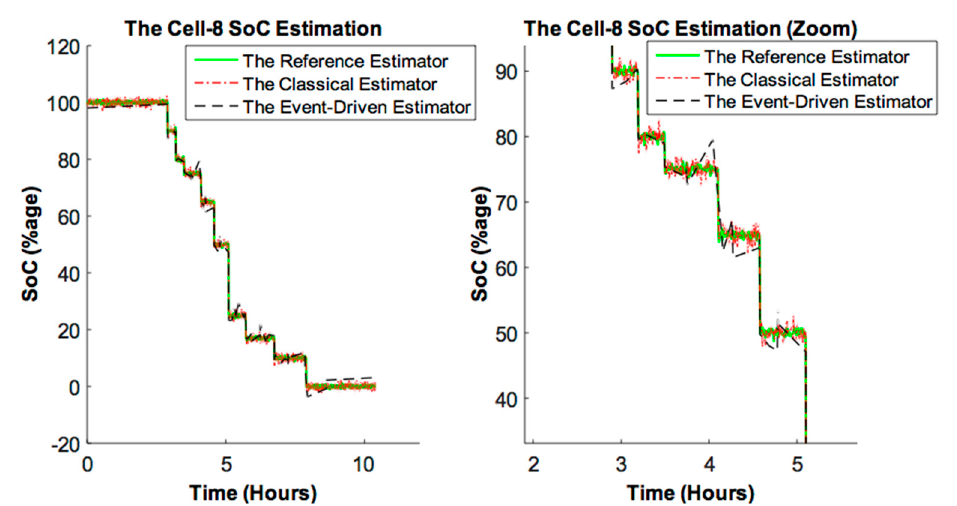
Figure 13. The cell-8 SOC curves.